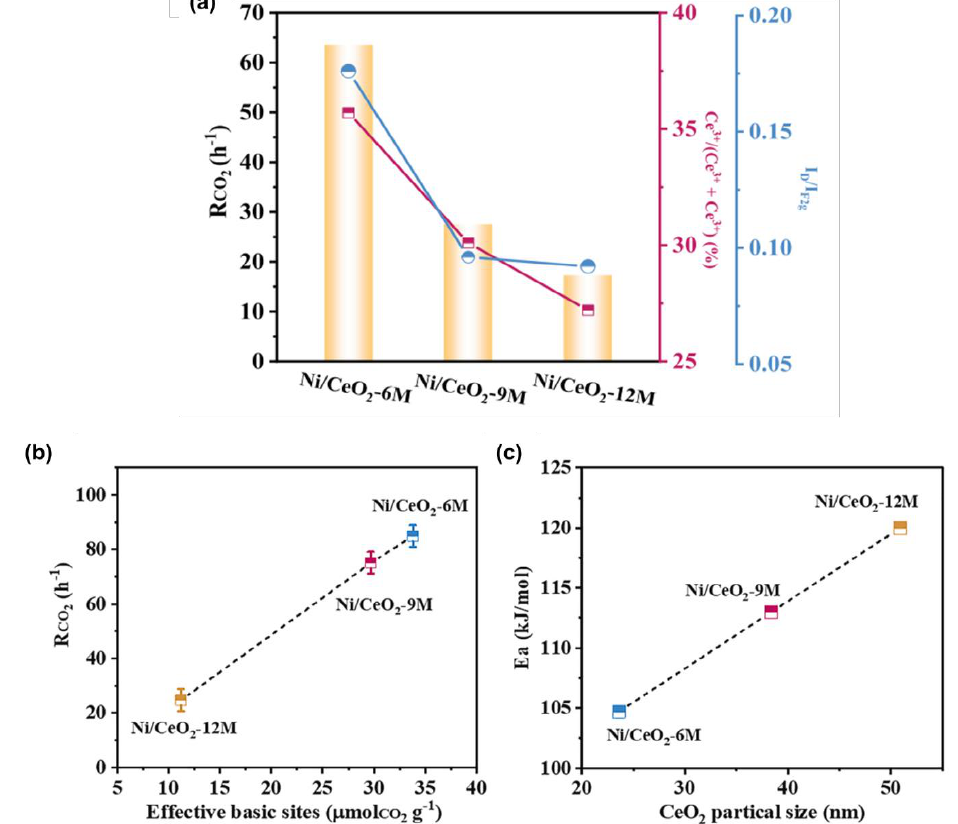
Figure 28. Correlation of turnover frequency with NaOH concentration and ceria reducibility ( a ), reaction rate at 548 K versus effective (sum of weak and medium) basic sites ( b ) and apparent activation energy values ( c ) as a function of CeO 2 nanocubes size. Reproduced with permission from Ref. [246]. Copyright© 2023, Elsevier.